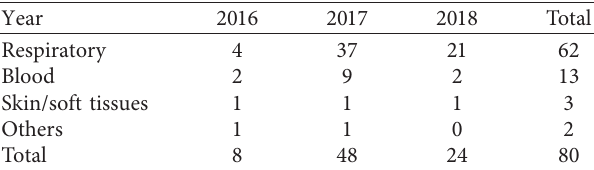
Table 2: Distribution of clinical isolates according to sample type and year in the intensive care units over the study period.